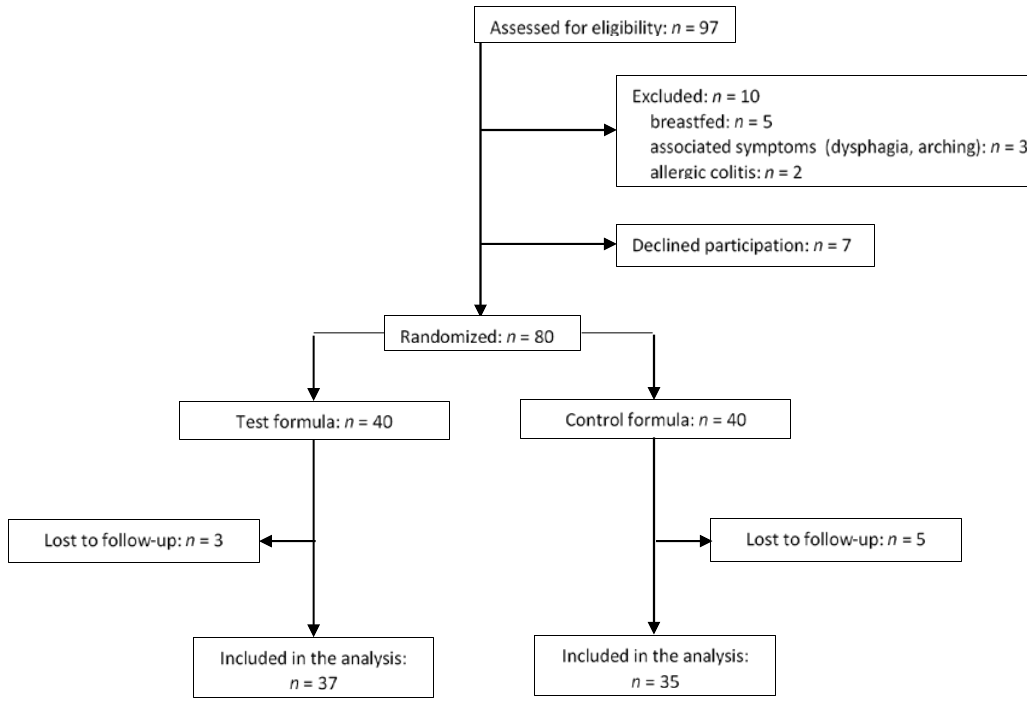
Figure 1. Flow diagram of study enrolment, allocation to the study groups and study dropout. At baseline, infants were, on average, 60 days old, weighed 5.6 kg, and had approximately seven episodes of regurgitation per day. No baseline differences in fasting antral areas (Table 1), GErate (test group: median − 54.9% [5th percentile = − 75.6%, 95th percentile = − 44.2%]; control group: median − 55.3% [5th percentile = − 85.2%, 95th percentile = − 44.3%]), age, anthropometric parameters